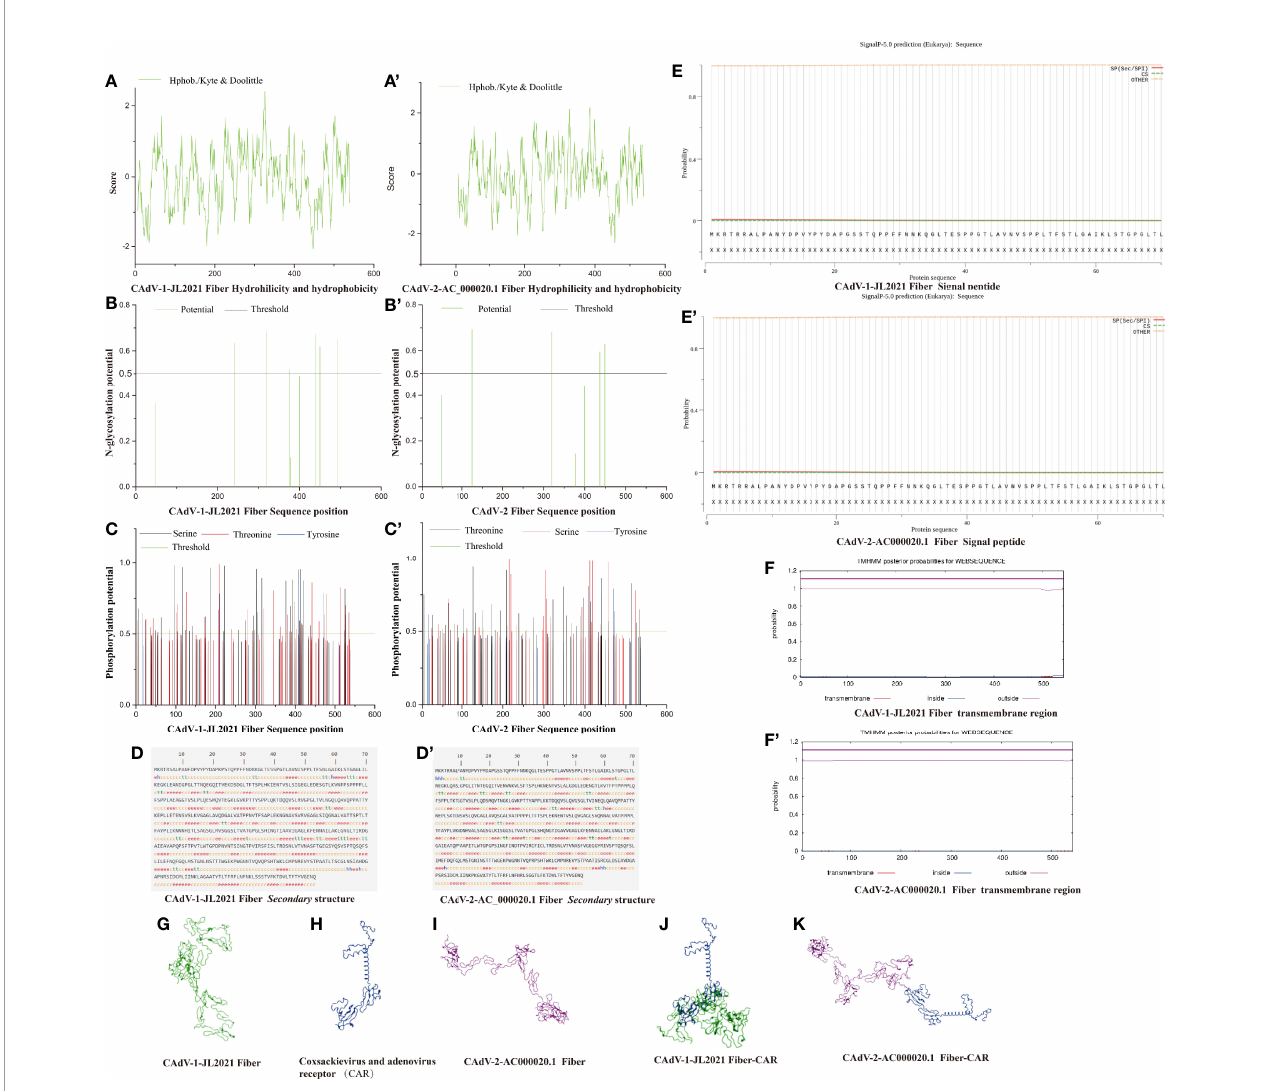
FIGURE 3 | The structure prediction of the Fiber protein. (A) CAdV-1 JL2021 Fiber Hydrohilicity and hydeophobicity; (A ’ ) CAdV-2-AC_000020.1 Fiber Hydrohilicity and hydeophobicity; (B) CAdV-1 JL2021 Fiber N-glycosylation potential position; (B ’ ) CAdV-2-AC_000020.1 Fiber N-glycosylation potential position; (C)